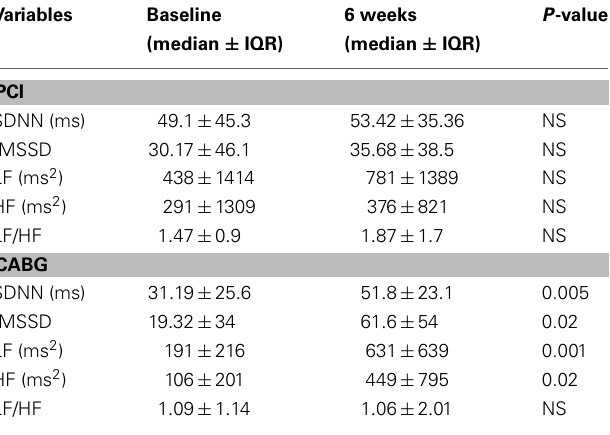
Table 3 | Changes of the HRV indices in PCI and CABG